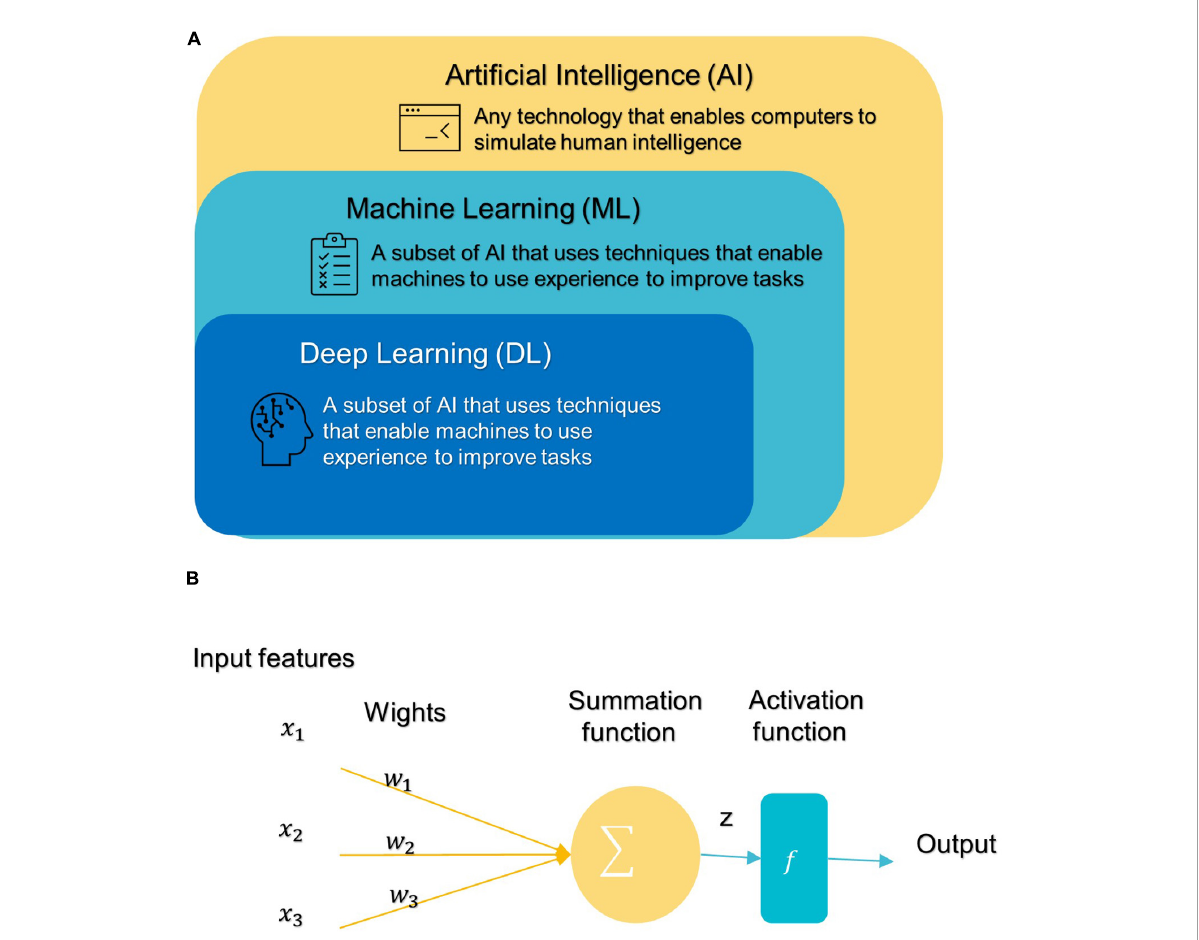
FIGURE3 (A) Branches of Artificial Intelligence Science. (B) An artificial neuron’s architecture. Each input × is associated with a weight w. The sum of all weighted inputs is passed onto an activation function f that leads to an